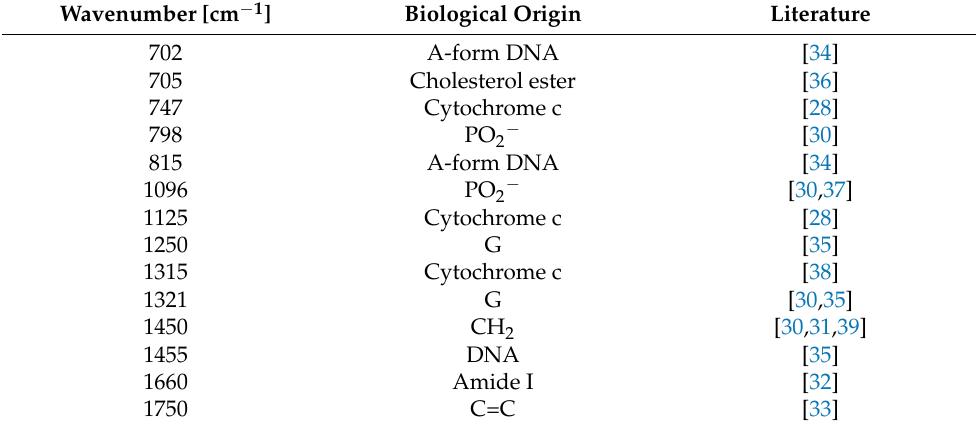
Table 1. Biological assignment of the most relevant